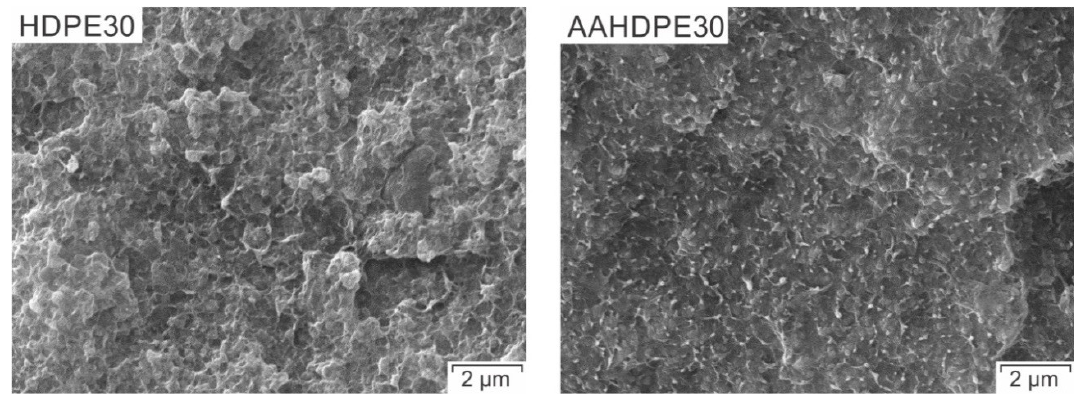
Figure 4. Morphology of the strands produced in the capillary rheometer and cryo-fractured of the compounds of HDPE and AAHDPE filled with 30 vol% of zirconia.